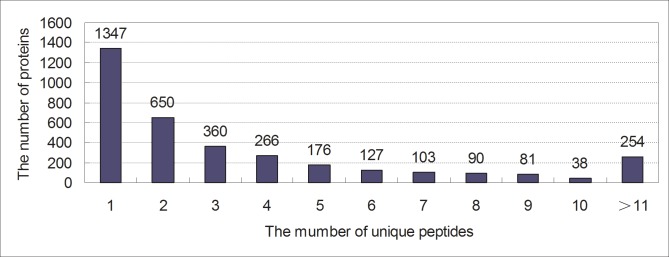
Unique peptides for the identified proteins.The number of proteins in each category is presented at the top of each bar.